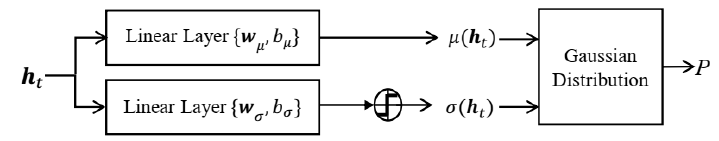
Figure 3. The architecture of a Gaussian approximation module.